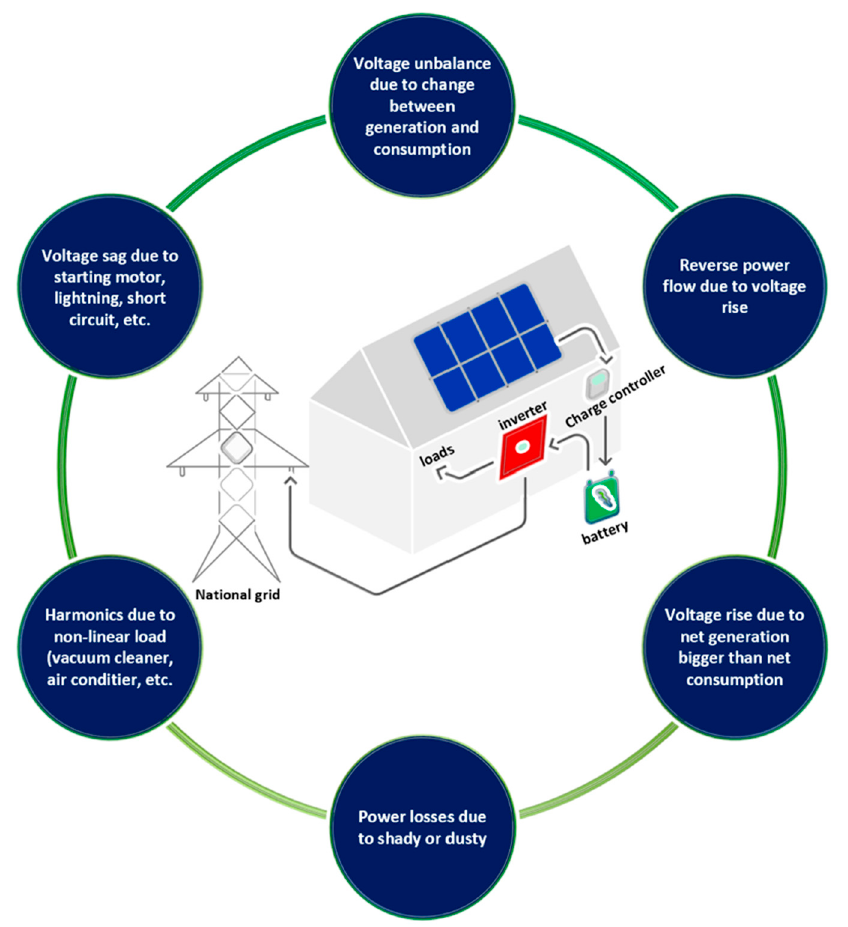
Figure 2. Impacts of rooftop PV .